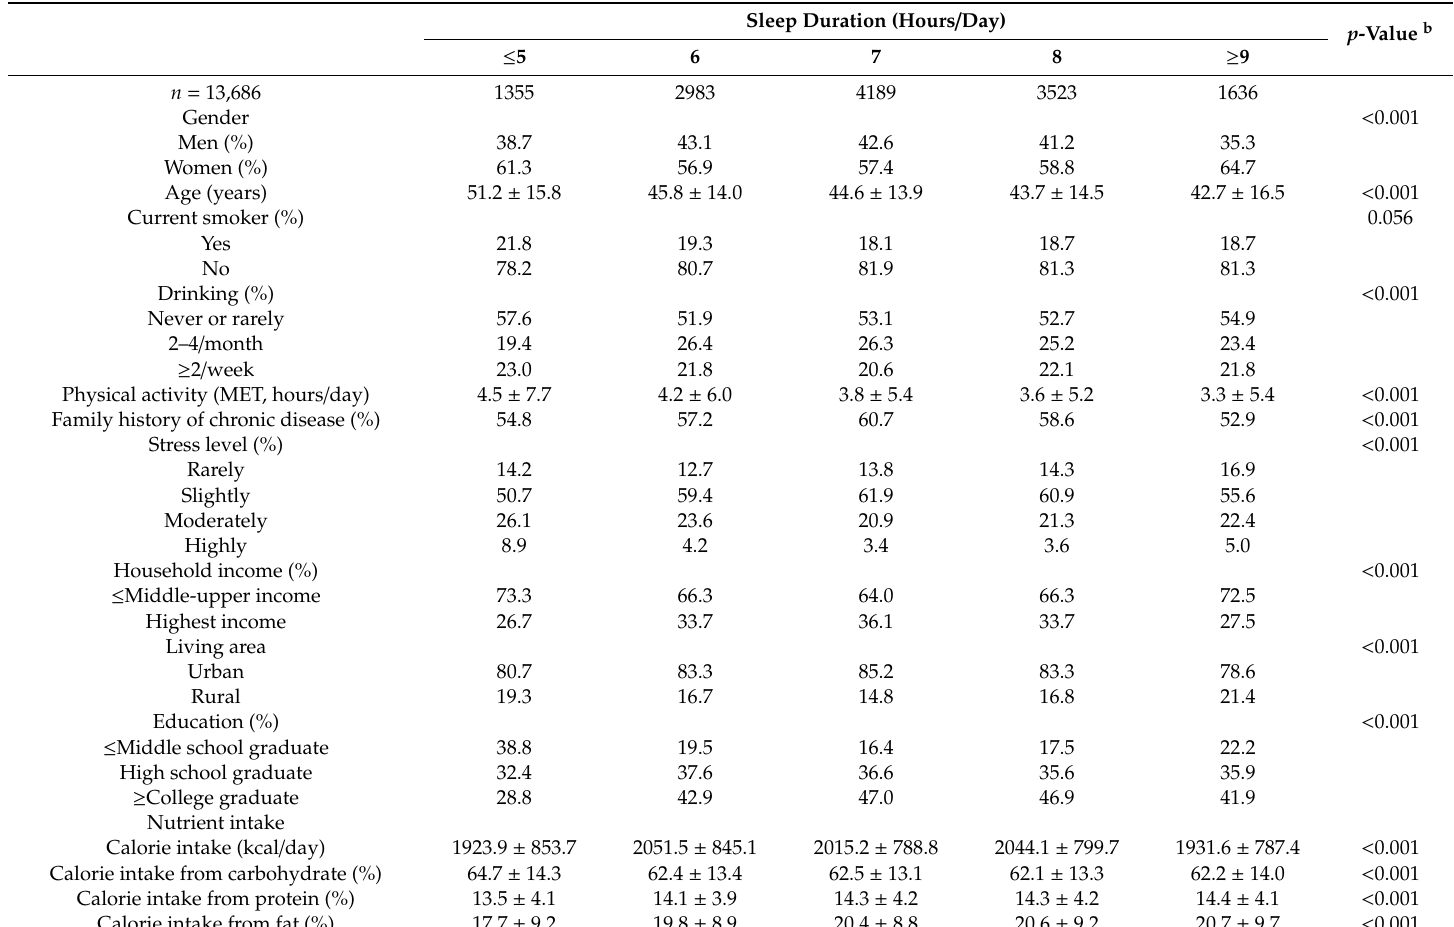
Table 1. General characteristics a of the study subjects according to sleep